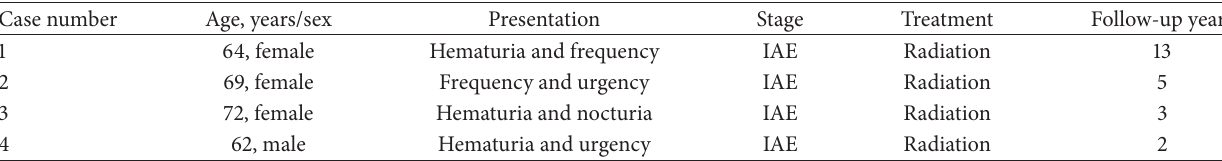
Table 1: Clinical Summary of the four cases.